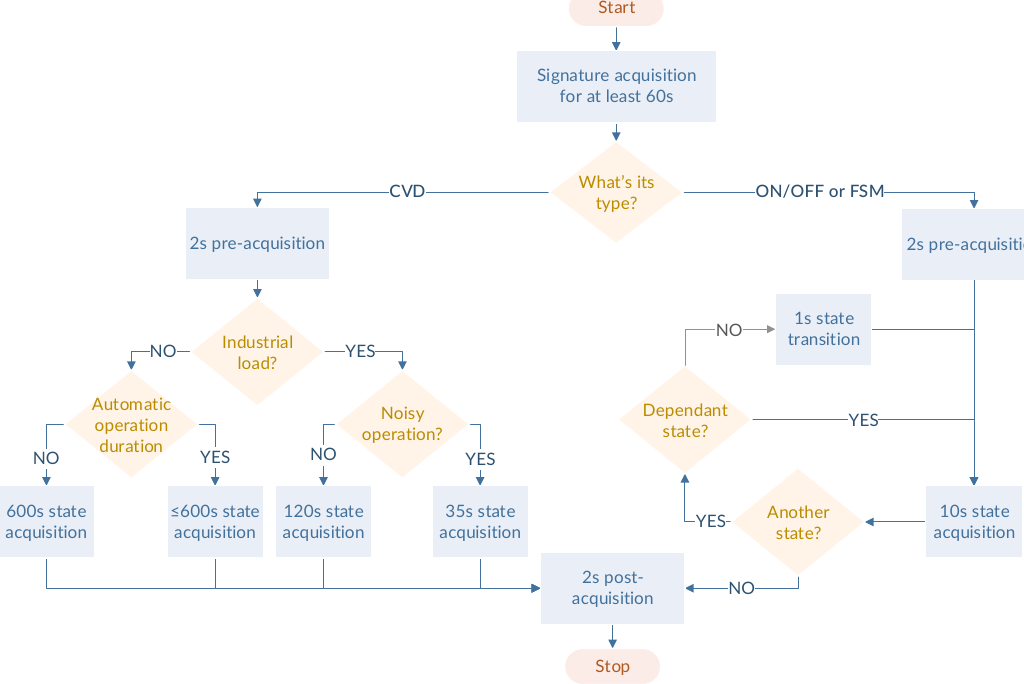
Figure 9. Flowchart underlying the process of IL signature